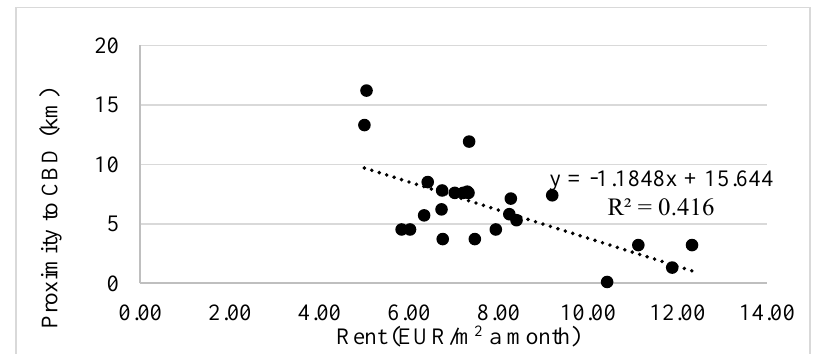
Fig. 1. Correlation between the rent and proximity to the CBD (developed by the authors, based on Renting Prices,